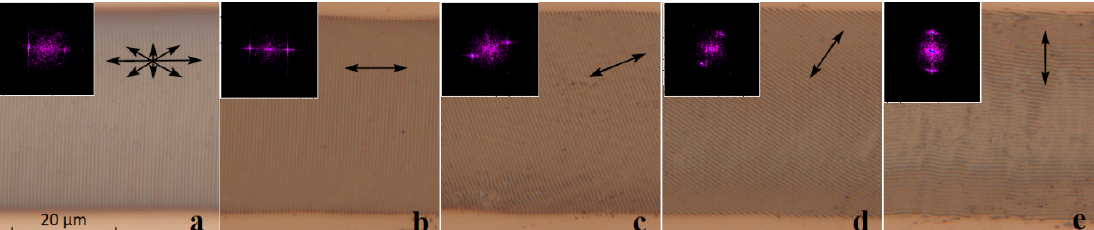
Figure 3. Optical micrographs of LIPSSs recorded in the same energy regime: τ = 4 ns, P av = 90 mW, f = 50 kHz, ε = 20 mJ / cm 2 . ( a ) Original partially polarized laser beam. ( b – e ) Linearly polarized radiation, where double-sided arrows indicate the direction of the polarization plane (at 0, 30, 60, and 90 ◦ to the scanning direction respectively). Insets show 2D-FFT spectra of fragments of the corresponding images (spatial frequencies up to 2 µ m − 1 ).